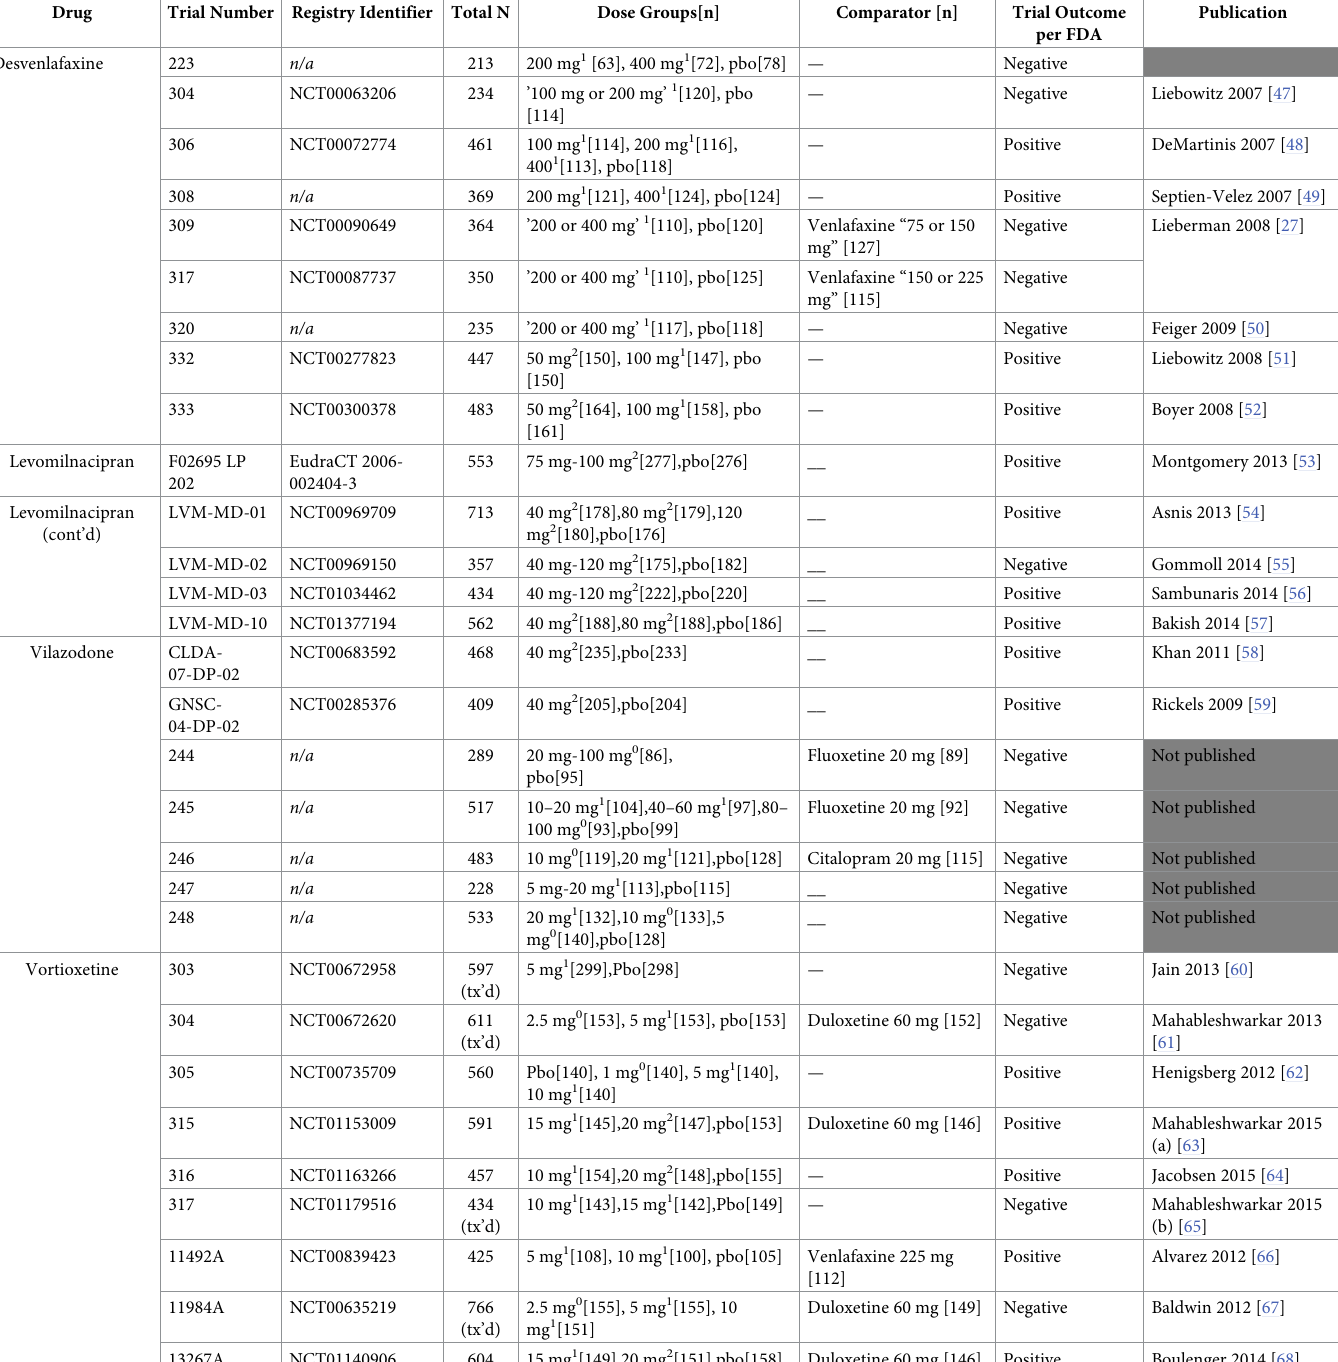
Table 2. FDA-registered trials and corresponding publications for cohort of 4 newer antidepressants. Drug